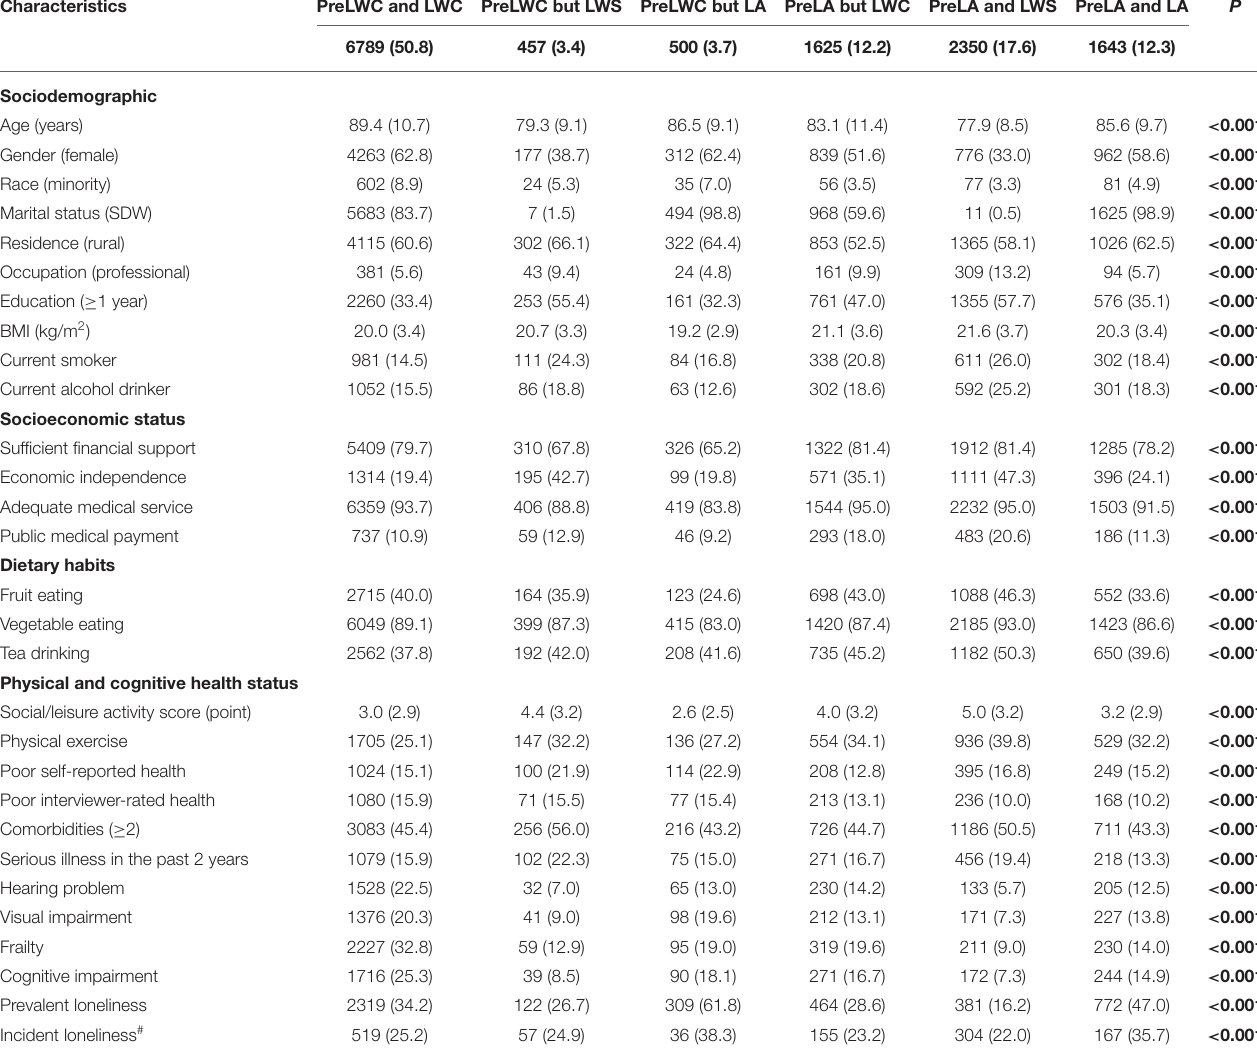
TABLE 2 | Baseline characteristics stratified by the combinations of living preferences and living arrangements.